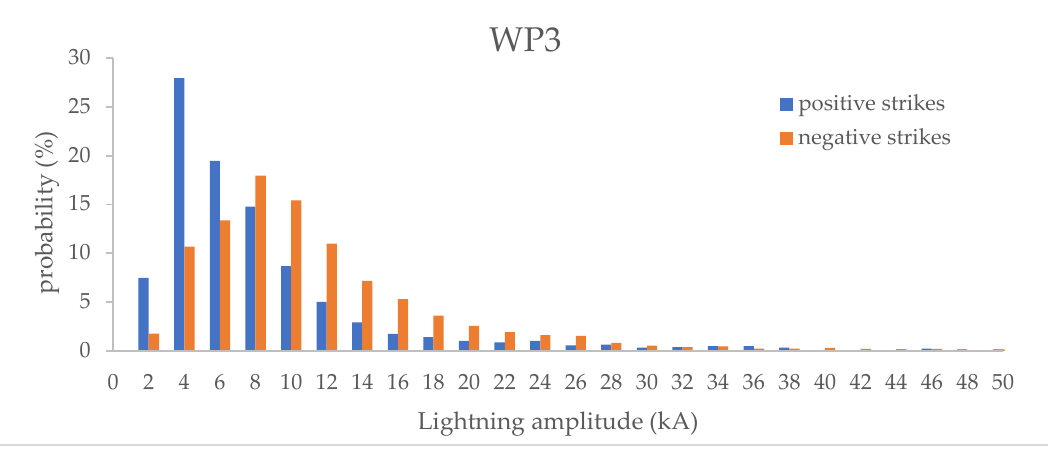
Figure A4. Lightning current amplitude probability distributions for positive and negative strikes extracted from the rec- orded incidents throughout the period 2011–2020 for WP4. Figure A5. Lightning current amplitude probability distributions for positive and negative strikes extracted from the rec- orded incidents throughout the period 2011–2020 for WP5.